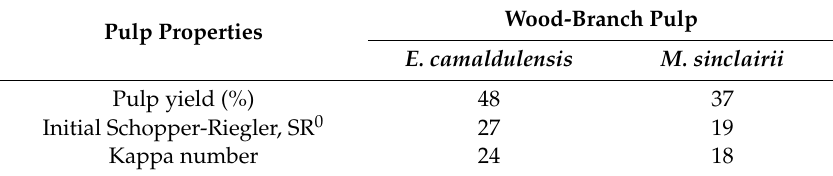
Table 4. Unbleached pulp characteristics after cooking